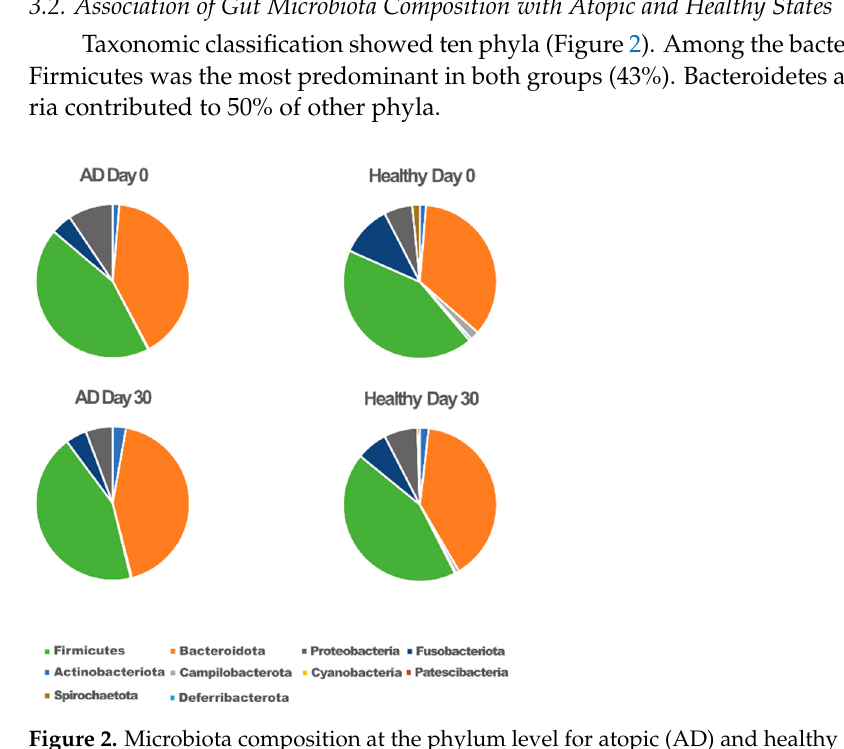
Figure 2. Microbiota composition at the phylum level for atopic (AD) and healthy